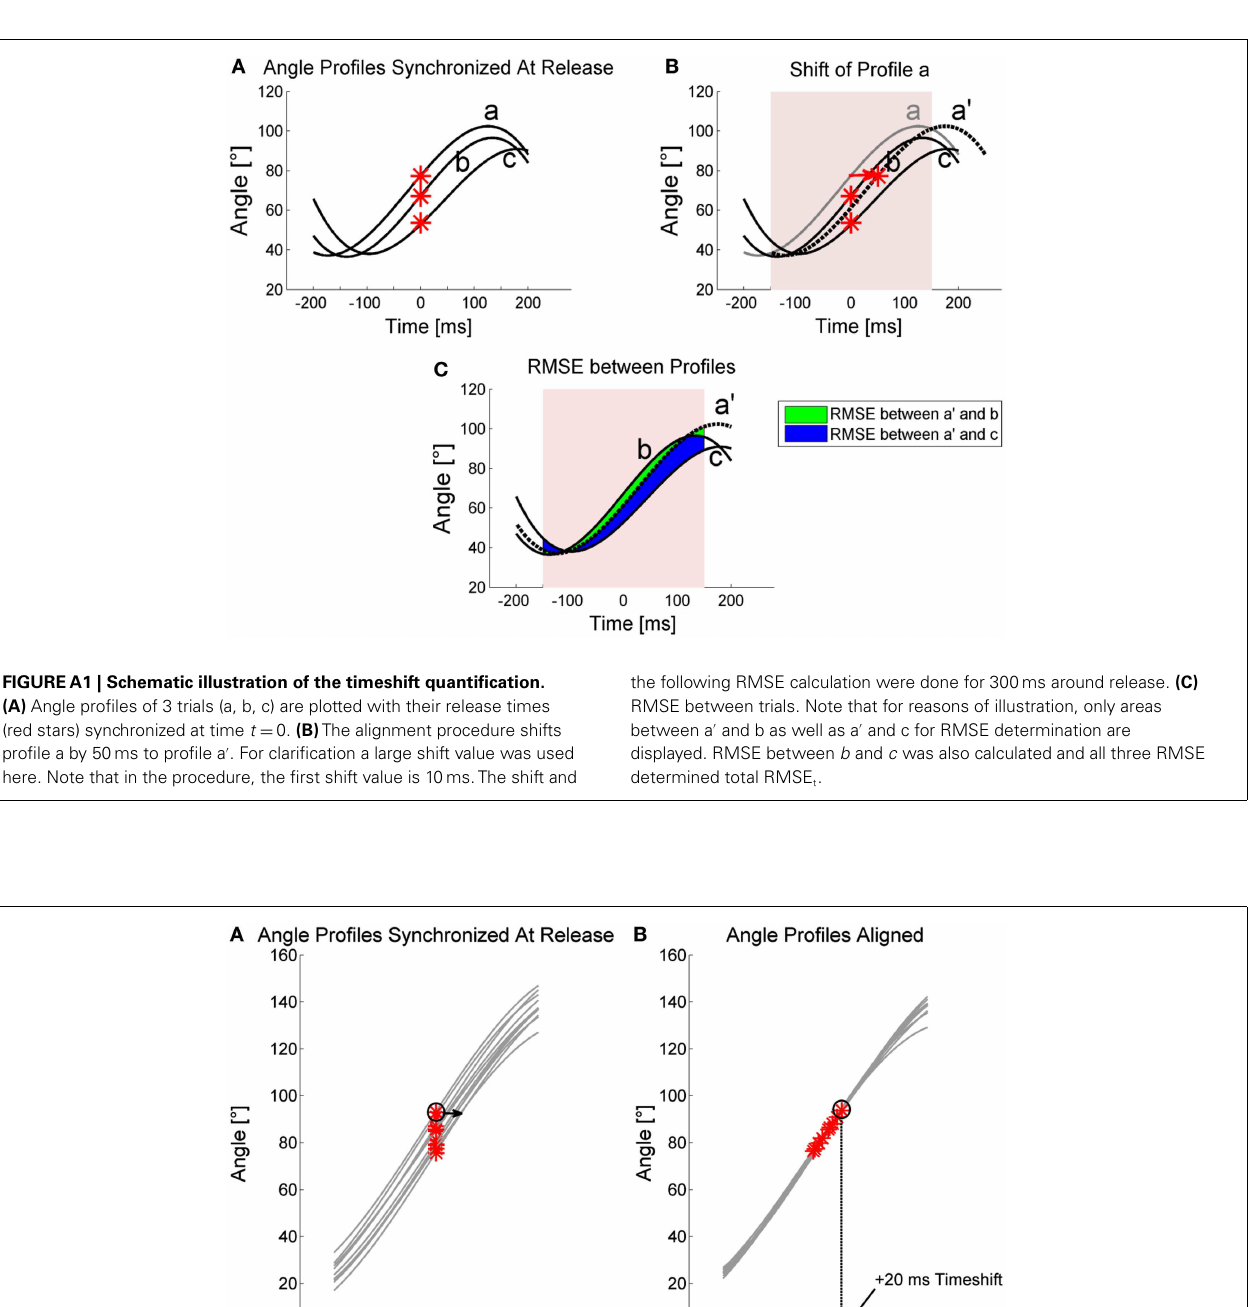
between the profiles. (B) Result of alignment optimization. Release points are positive or negative in the time dimension which equals the timeshift values. Encircled is one release point shifted by 20ms by the